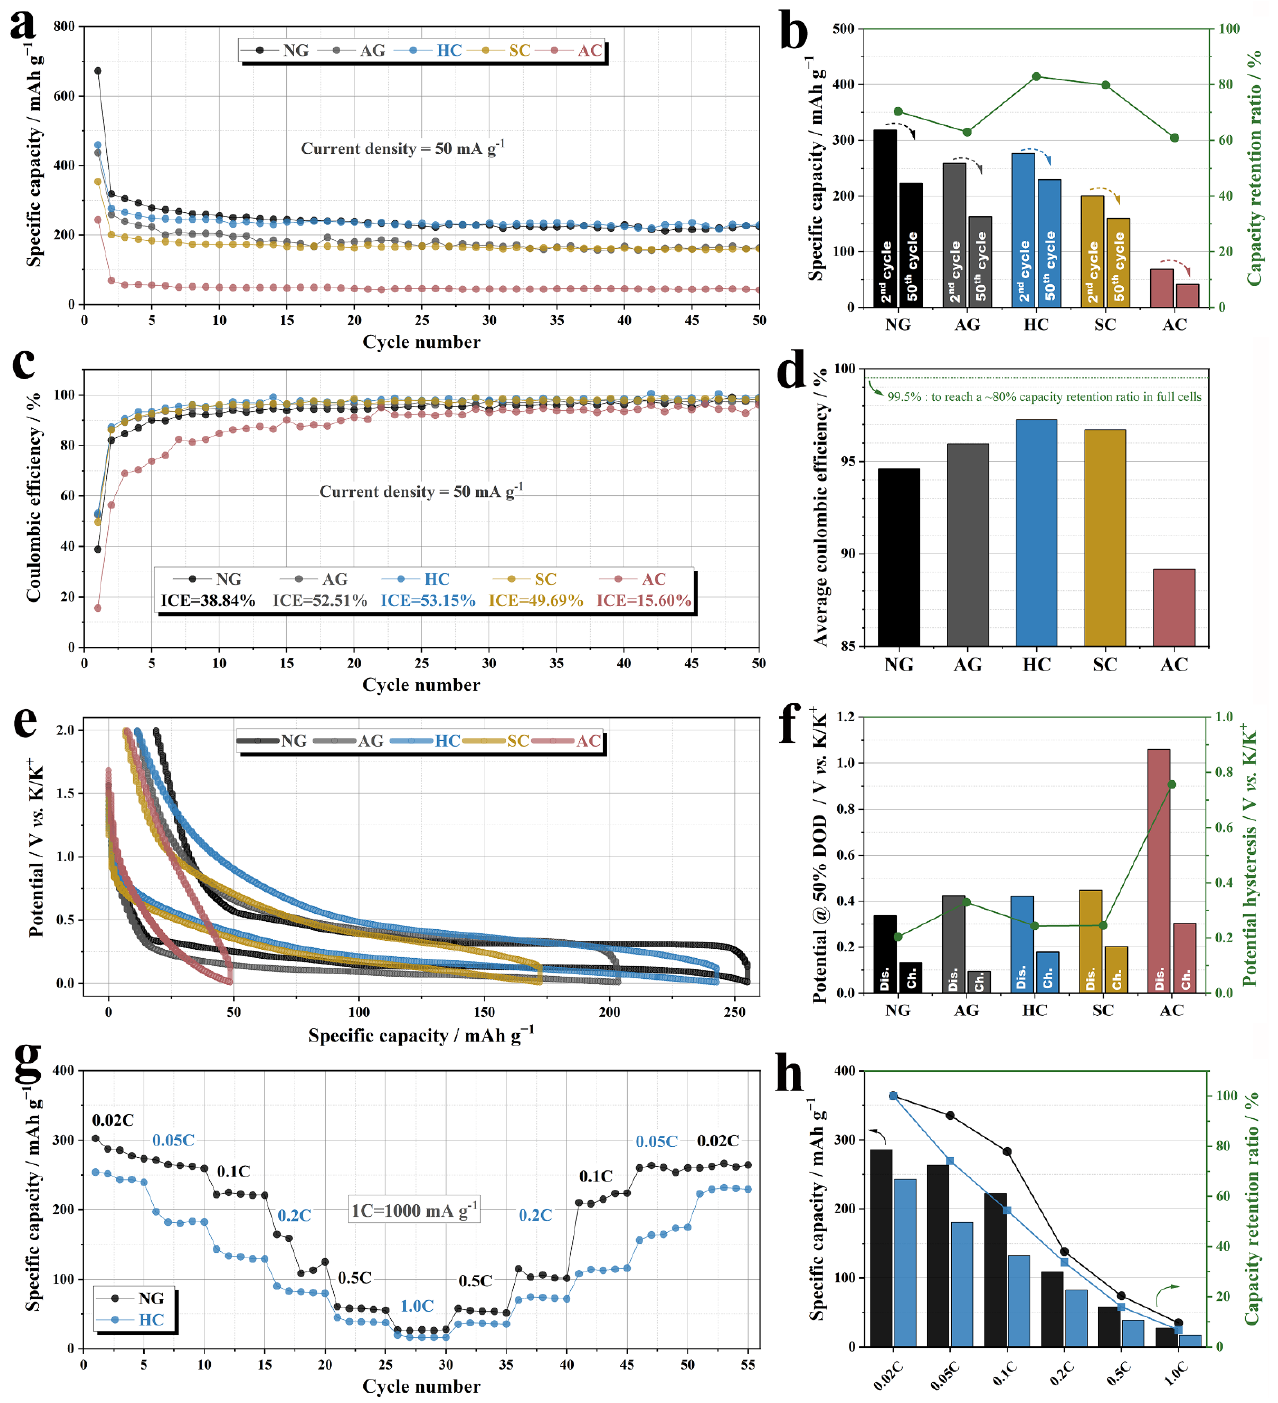
Figure 3. Electrochemical performance. ( a , b ) Cycling stability, ( c , d ) Coulombic efficiency, ( e ) Charge – discharge profiles, and ( f ) Potential hysteresis at 50 mA g −1 , ( g ) Rate capability of NG and HC from 0.1C to 1.0C (1.0C = 1000 mA g −1 ) and ( h ) corresponding capacity retention ratios at various rates.